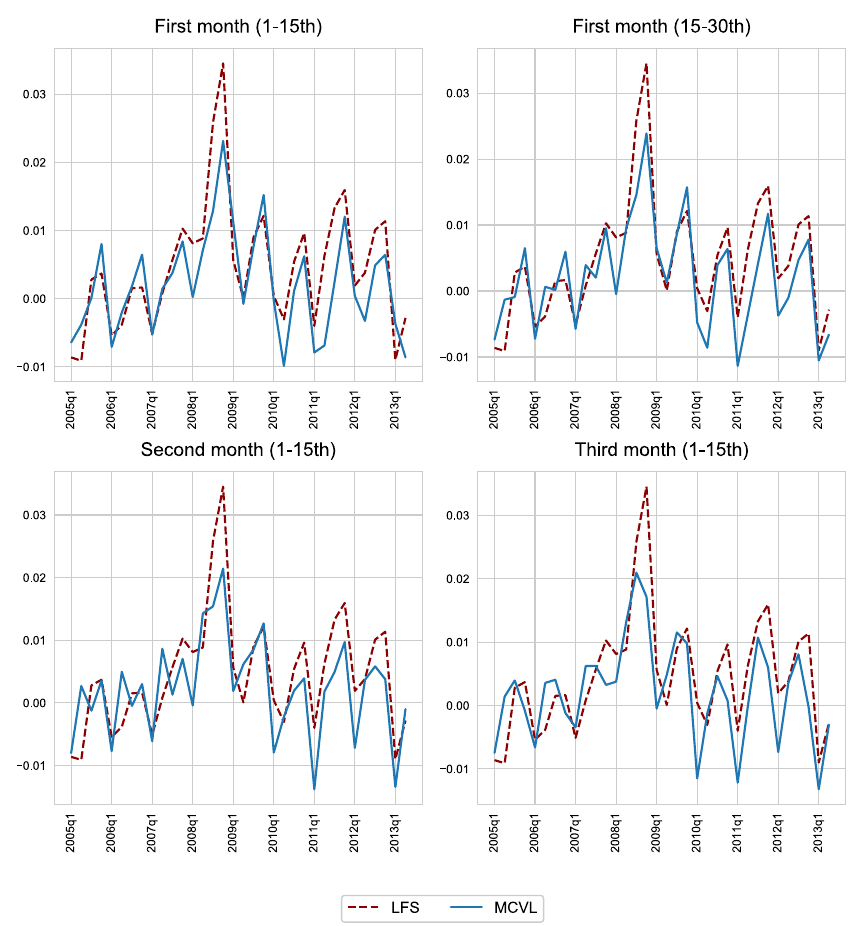
Fig. 26 Seasonality of unemployment by reference week, raw